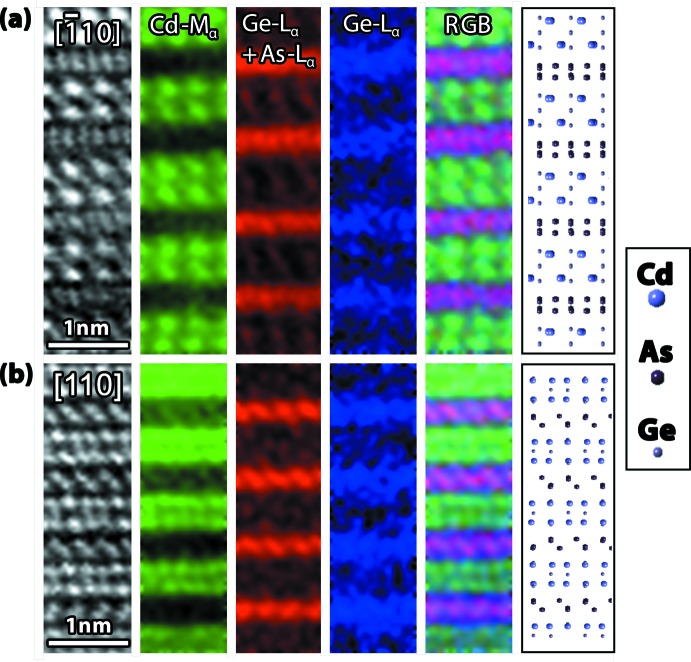
Atomic column EELS maps for two crystallographic poles, i.e., (a) [10] and (b) [110], in the trigonal system to different regions within the crystal (note these are rotated 90° from the images in Fig. 6 ▸).